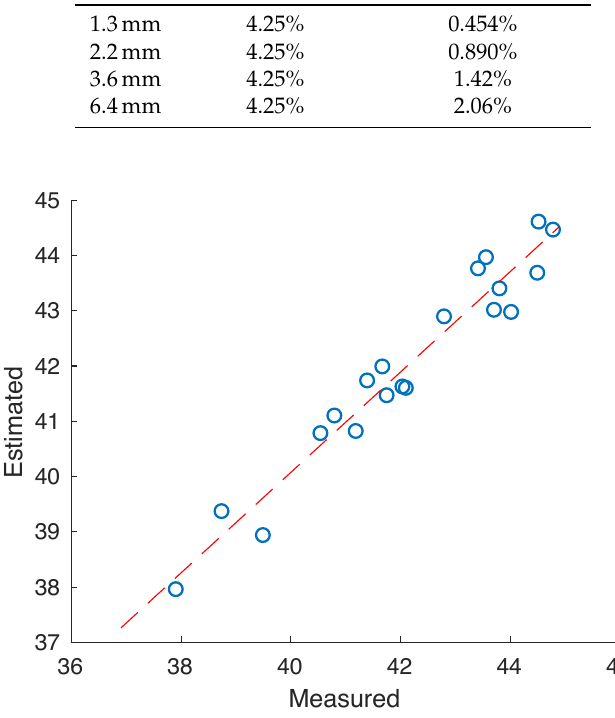
Figure 7. Permittivity estimated from the ˆ E 2 n weighted average compared to those measured from numerical simulations. A strong positive correlation was confirmed using Spearman’s method ( p < 0.001, R 2 =